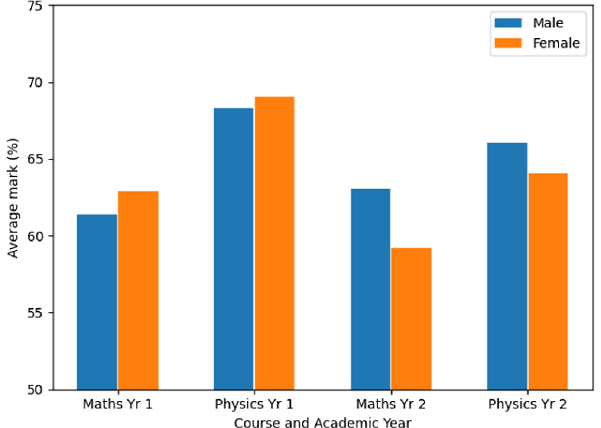
FIG. 4. Academic performance of male and female first year entry students in first and second academic year mathematics and physics courses ( N ¼ 105 , Male ¼ 69 , Female ¼ 36